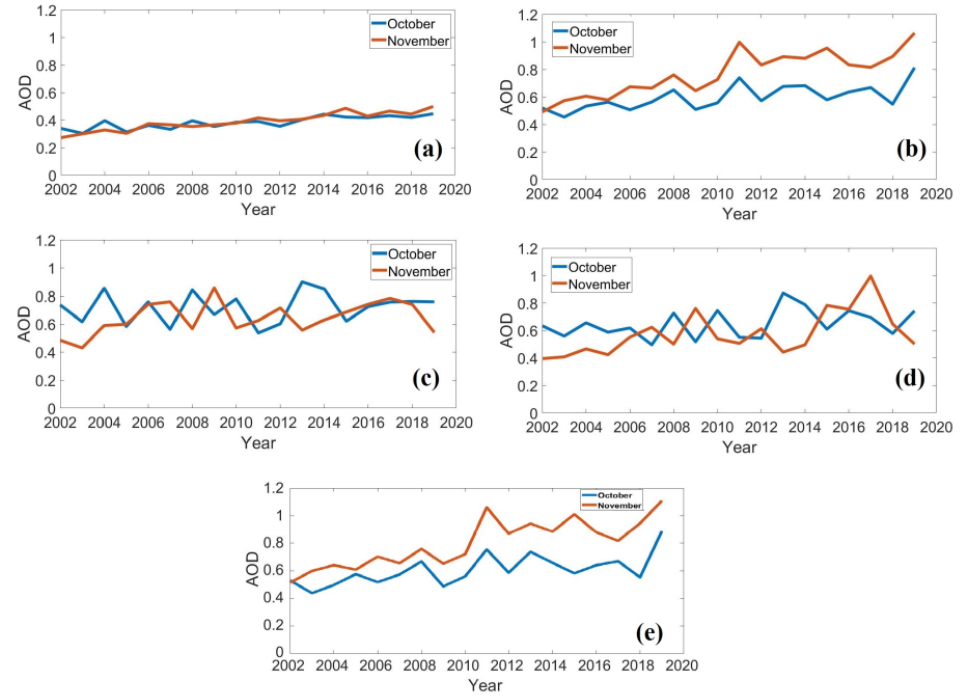
Figure 2. Time series of AOD over ( a ) Indian region 60° E – 90° E, 20° N – 40° N), ( b ) Northwestern region (70° E – 76° E, 29° N – 32° N), ( c ) Delhi region (76° E – 78° E, 27° N – 31° N), ( d ) Lucknow region (78° E – 81.5° E, 26° N – 28° N), and ( e ) Patna region (82° E – 85° E, 25° N – 27° N).